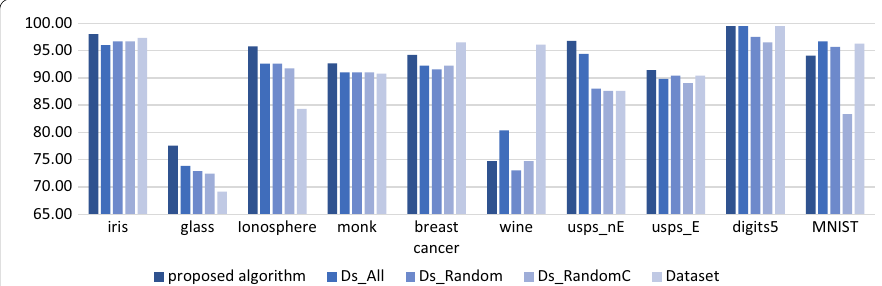
Fig. 6 Best Classification Accuracy of proposed method and other dissimilarity spaces on evaluation